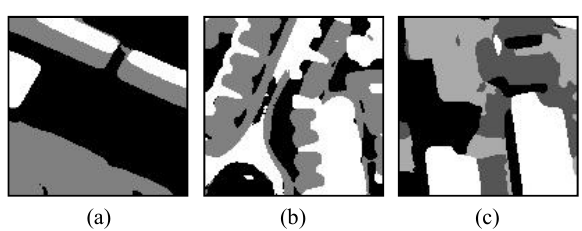
algorithm(a) Figure 2 Segmentation results of SVFMM